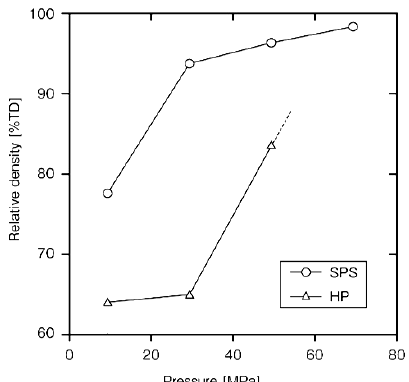
Figure 21. Dependence of relative density on applied pressure in the SPS-and HP-consolidated SiCs.